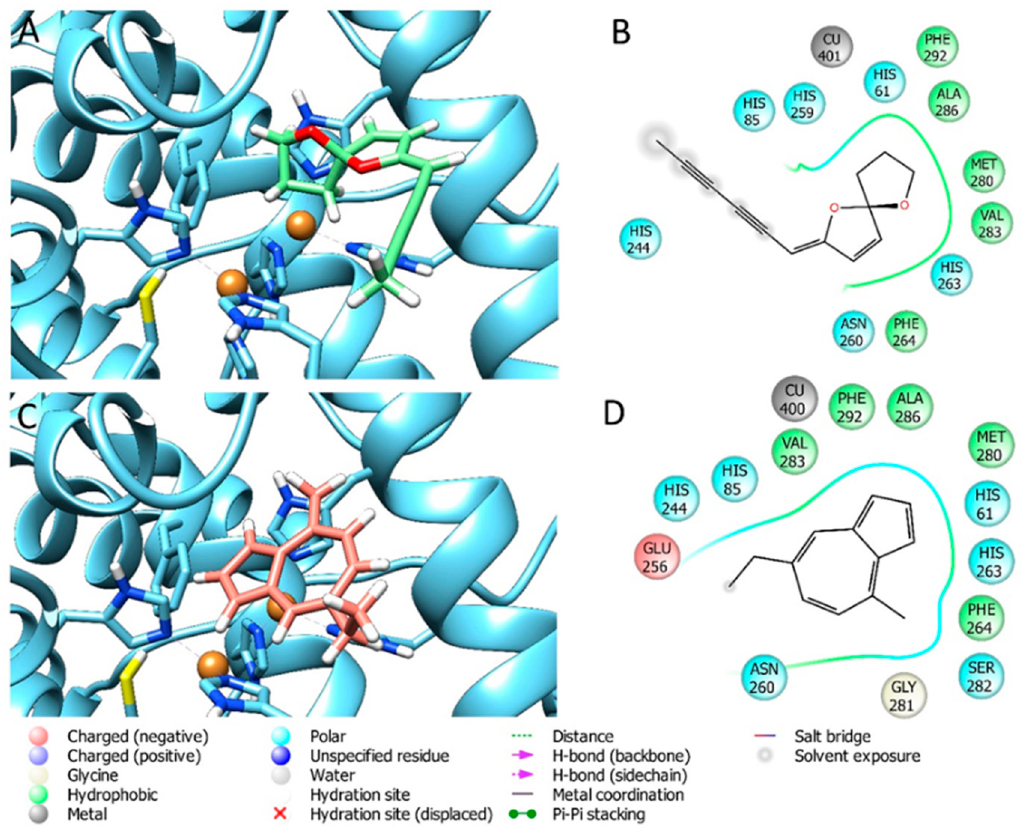
Figure 3. Best docking pose of CP4 ( A , B ) and CP5 ( C , D ) on tyrosinase.